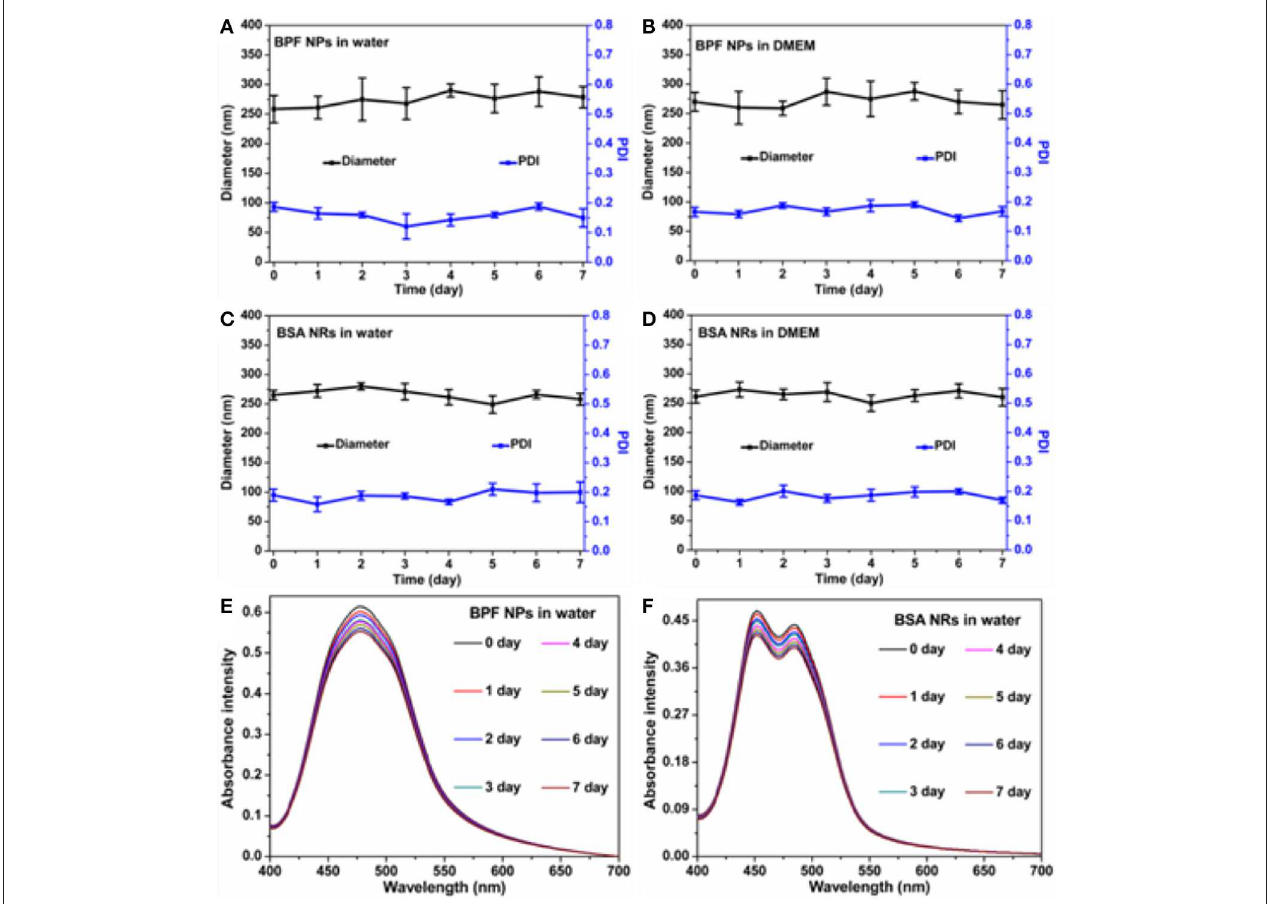
FIGURE 2 | Average size changes of BPF NPs (A,B) , BSA NRs (C,D) during 7 days in different solutions. The data are shown as the mean values ± standard deviation (SD) ( n = 3). The absorbance intensity of (E) BPF NPs and (F) BSA NRs during 7